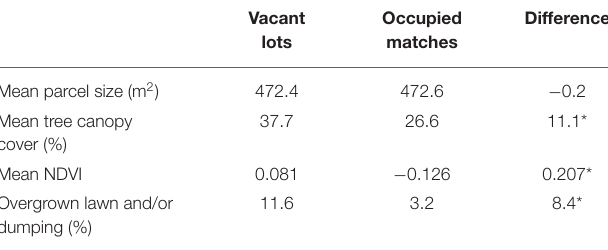
Vacant Occupied lots